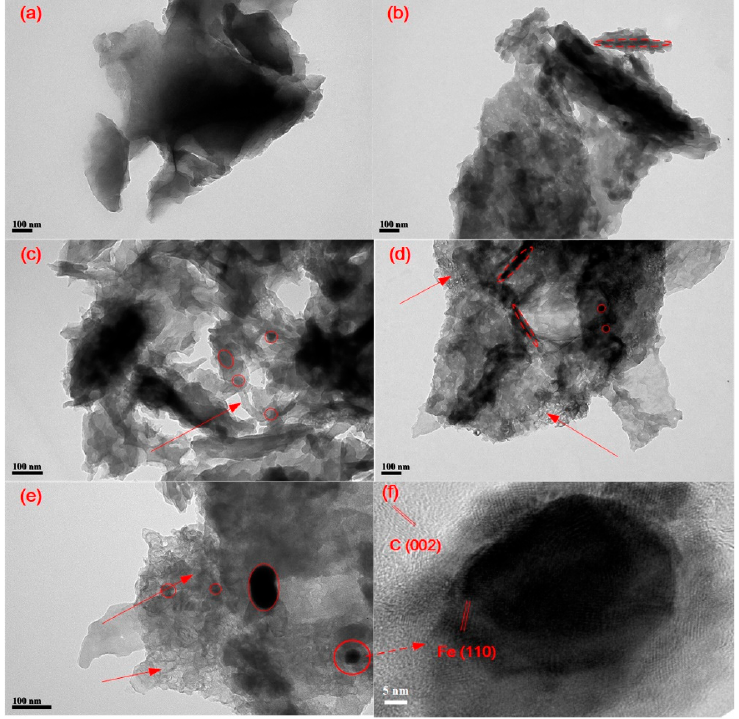
Figure 7. TEM micrographs of ( a ) neat PIM-1000, ( b ) FeNC-700A600, ( c ) FeNC-800A700, ( d ) FeNC- 900A800, ( e ) FeNC-1000A900 and ( f ) HR-TEM of the tiny α - Fe particle in FeNC-1000A900.